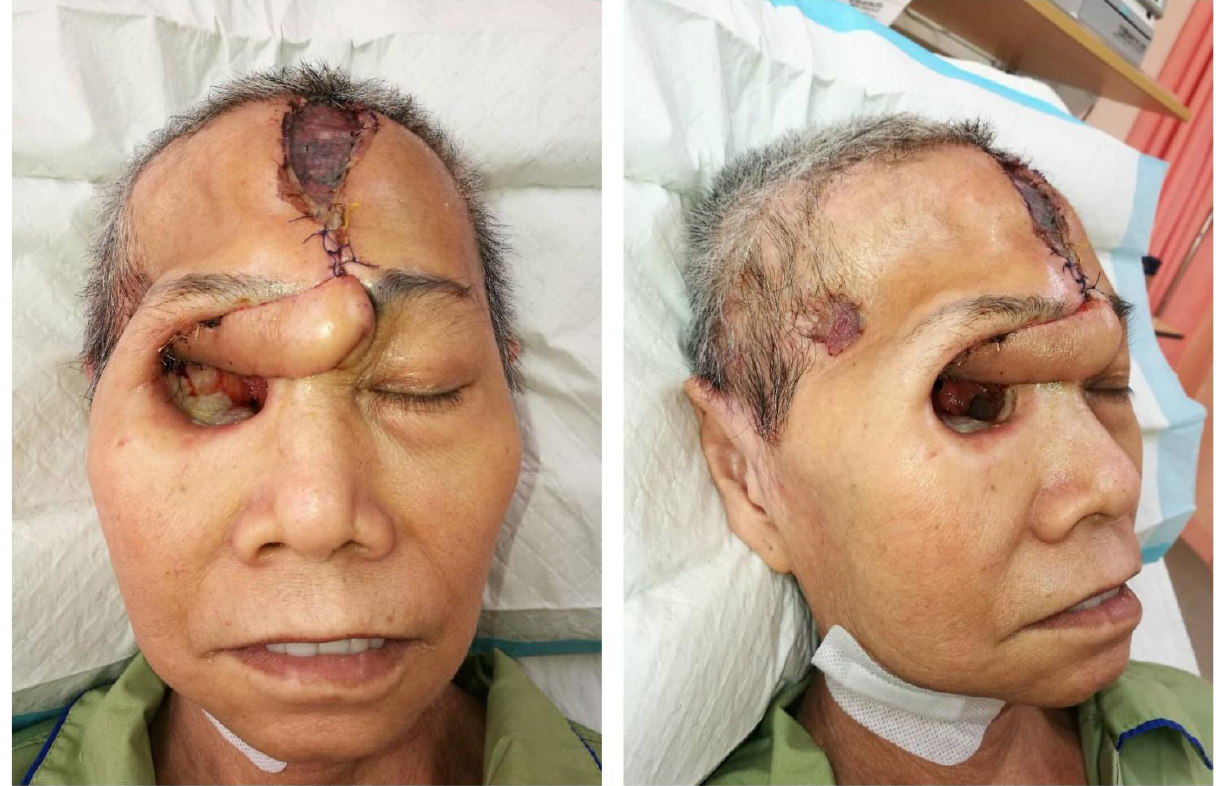
Figure 2: 1-week post paramedian forehead flap. The superior part of the donor site is covered with a split-thickness skin graft and the inferior part is closed primarily.